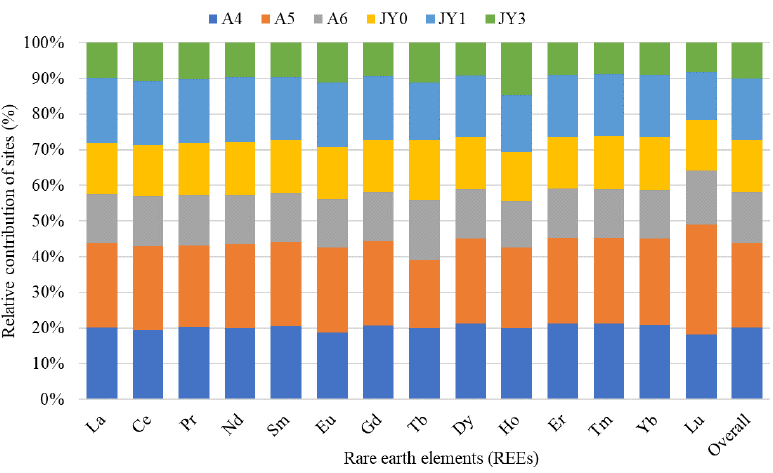
Figure 6. Relative contribution (%) of sites for rare earth elements (REEs) in JRE obtained by the singular value decomposition (SVD) analysis and employing Equation (11).